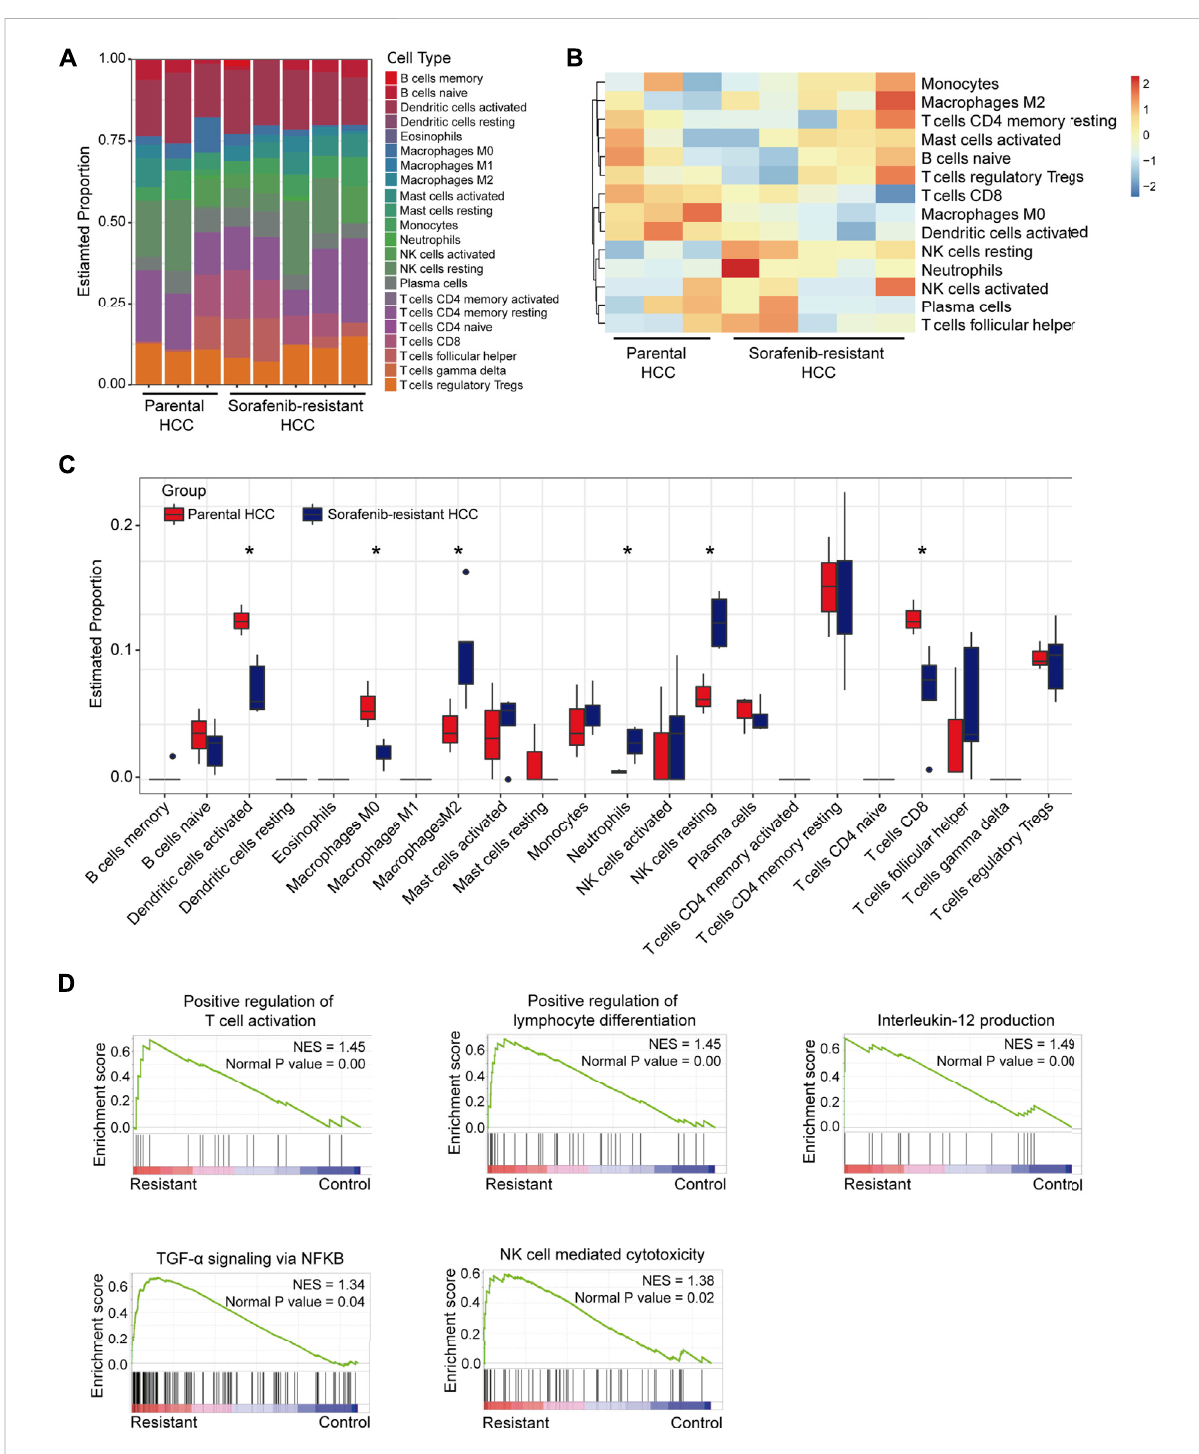
FIGURE 1 Immunocyte in fi ltration levels and immune-associated signaling pathways in sorafenib-resistant HCC. (A) In fi ltration levels of 22 types of immune cells in fi vesorafenib-resistantand threeparentalHCCxenografts. (B) In fi ltration heatmap ofmajor 14 types ofimmunecells. (C) In fi ltration differences of 22 types of immune cells between sorafenib-resistant and parental HCC xenografts. (D) Enrichment plots showing the immune- associated signaling pathways in sorafenib-resistant HCC